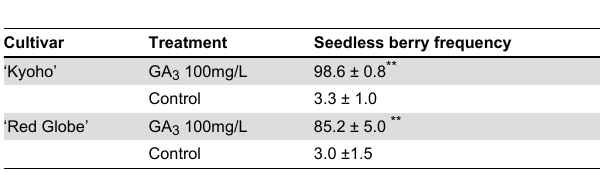
Table 1. Seedless berry frequency in GA untreated control ‘Kyoho’ and ‘Red globe’